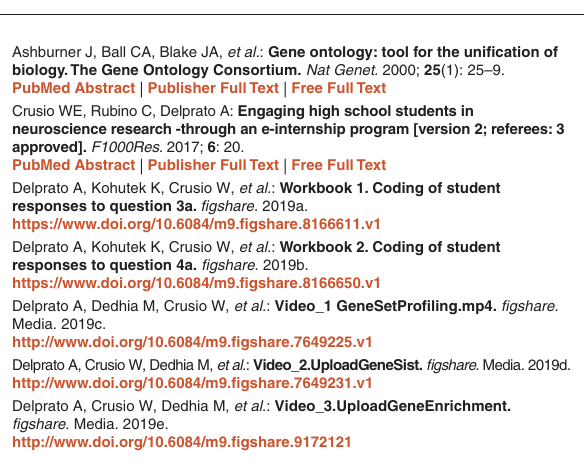
Figshare: Workbook 1. Coding of student responses to question 3a.